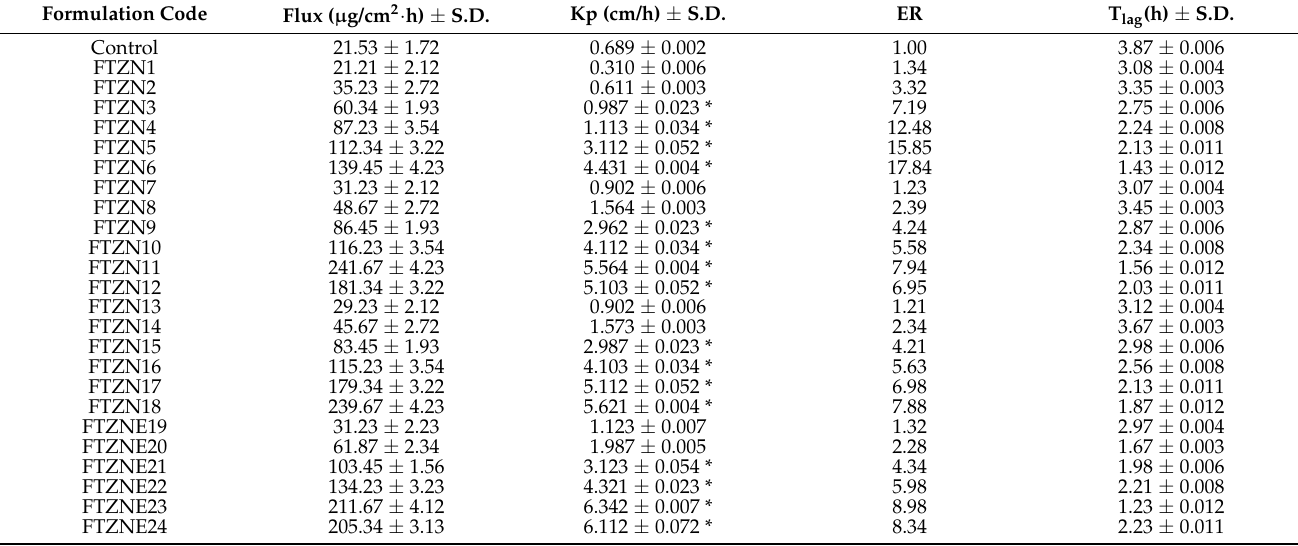
Table A6. Transdermal patches of tizanidine by using flaxseed oil and coriander oil as permeation enhancer through rabbit skin, n = 3, mean ± S.D. * Kp is significantly different from control formulation, p <